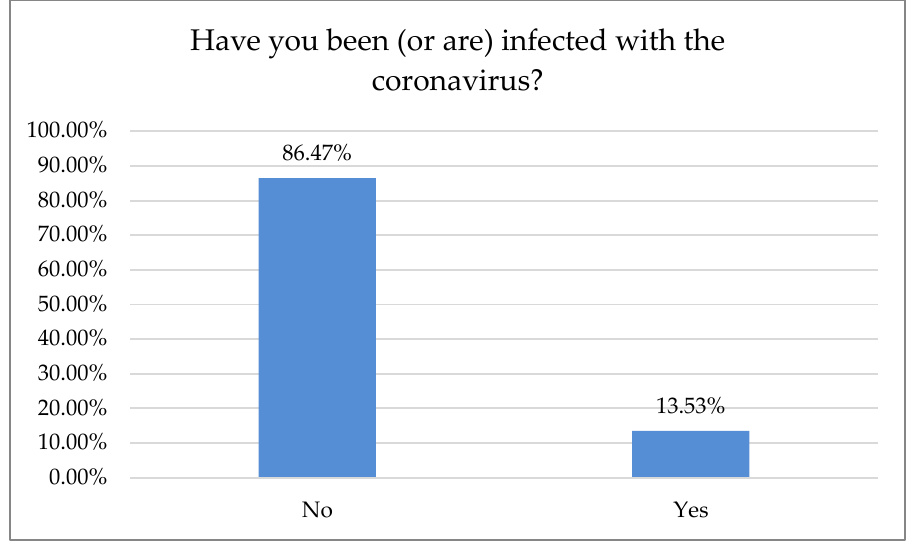
Figure 7. The number of COVID-19 cases among examined dentists. Of the respondents, 42.72% did not admit patients during the lockdown, 41.39% admitted only pain treatments, and 30.79% admitted patients with unfinished